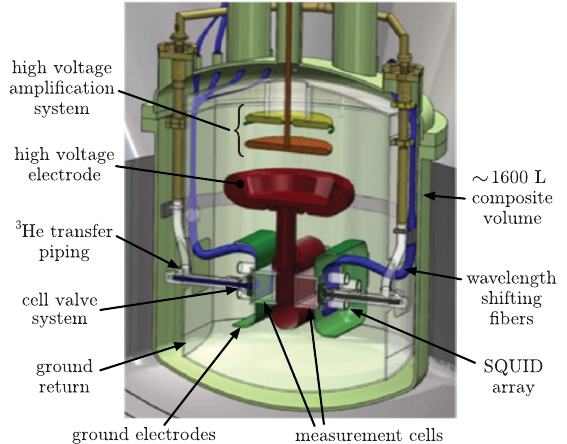
Figure 1. The design of the Central Detector System. The ∼ 1600 L volume, made from composite materials, is filled with superfluid 4 He cooled to ∼ 0 . 4K with a dilution refrigerator (not shown). This system contains the two measurement cells filled with isotopically pure superfluid 4 He along with systems for the electric field, light collection, 3 He cell valve, and SQUIDs. The cold neutron beam goes into the page. For scale, the inner cell dimensions are 7 . 5cm( W ) × 10 cm( H ) × 40cm ( L ) relative to the